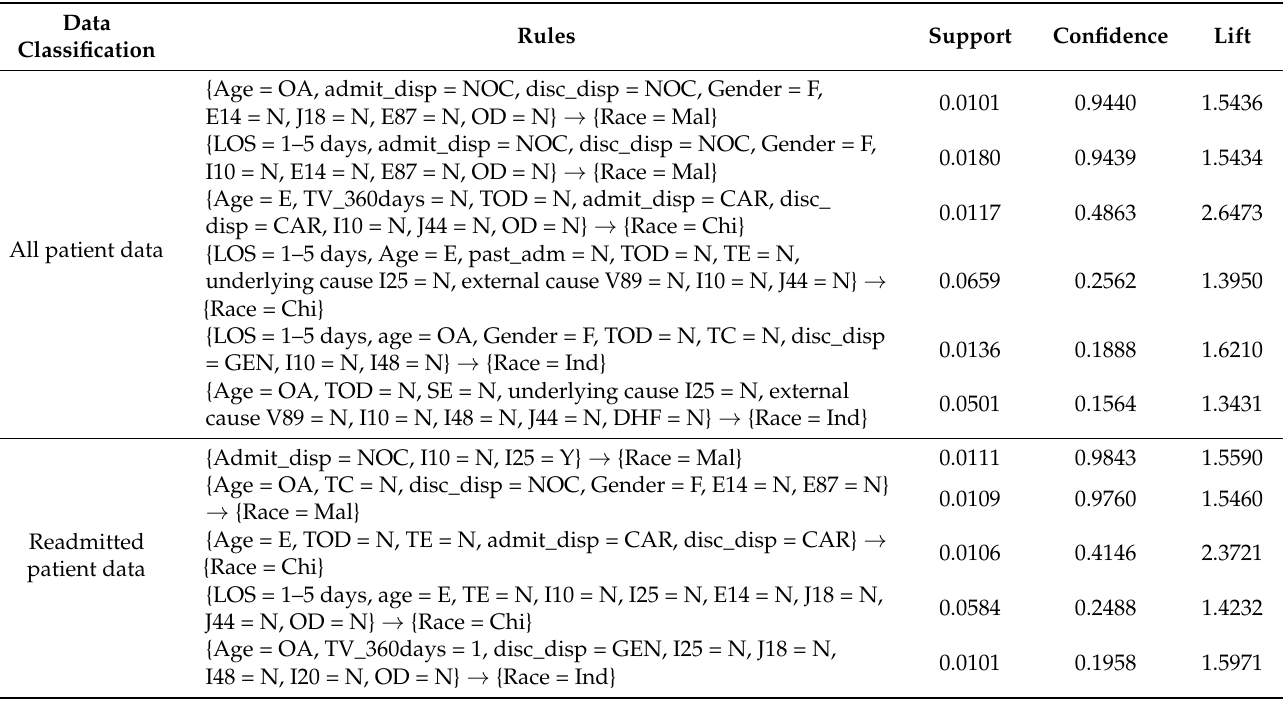
Table 5. Supervised association rule mined based on